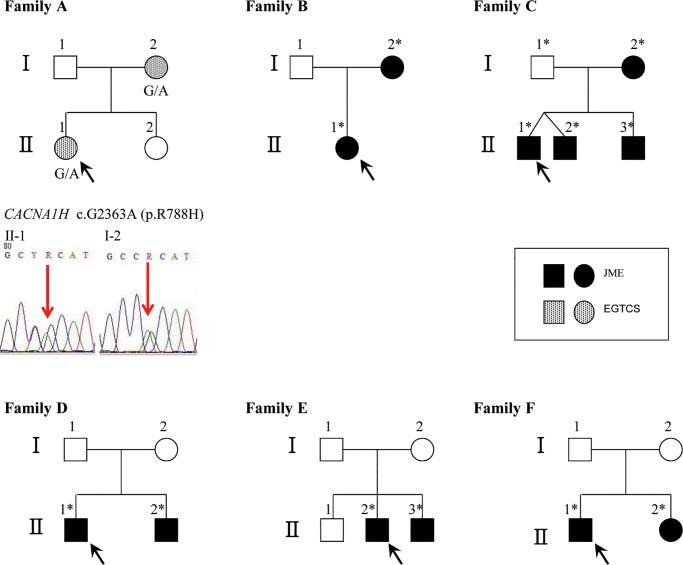
Pedigree of familial cases including 6 families and 14 patients.Black arrows indicate probands. Darkened symbols represent affected members. Stars indicate participants in the multi-gene panel testing. Vertical arrows indicate variant sites in the sequencing chromatograms. Sanger sequencing confirmed the CACNA1H heterozygous variant c.2363G>A, p.(Arg788His) in 2 patients (I-2 and II-1) from Family A. JME, juvenile myoclonic epilepsy; EGTCS, epilepsy with generalized tonic-clonic seizures.